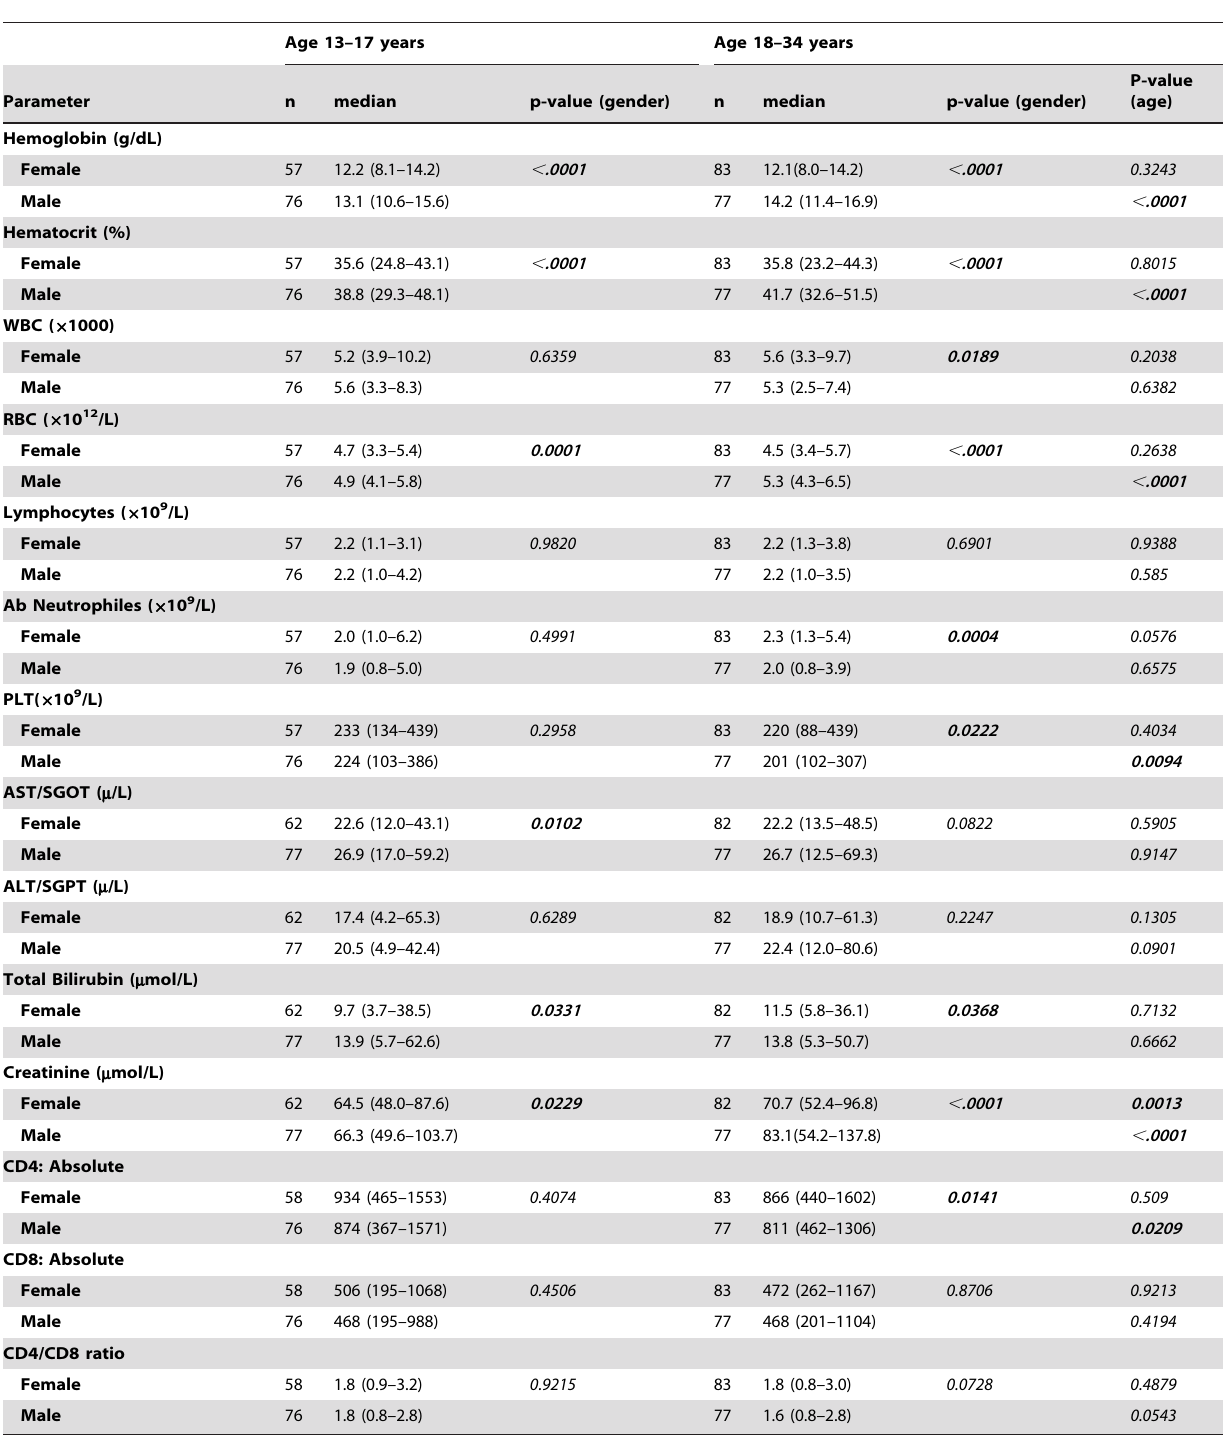
Table 2. Test of difference in hematologic, clinical chemistry and immunologic parameters between gender and age-groups from the 13–34 years old rural western Kenya cohort